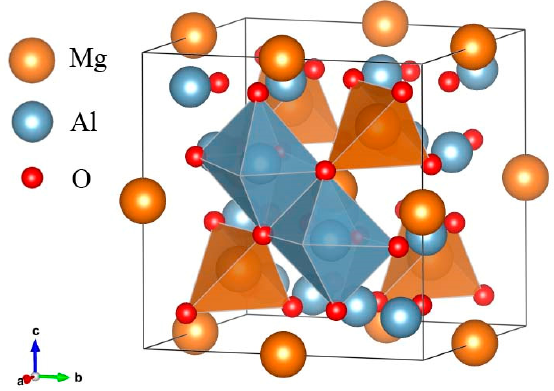
Figure 1. Crystallographic illustration of the MgAl 2 O 4 -spinel (normal spinel structure).